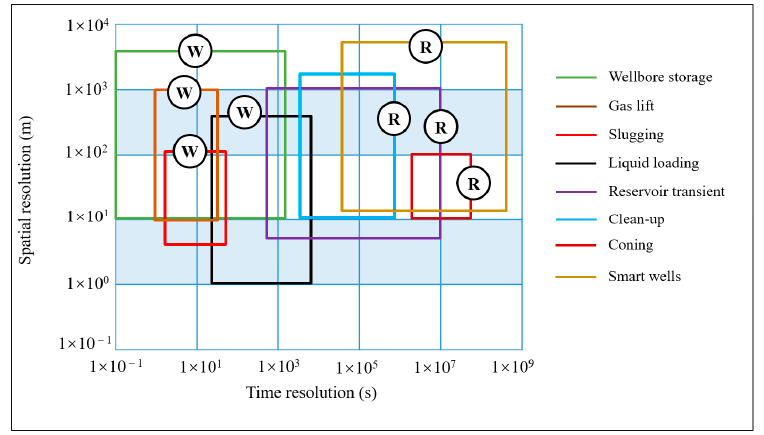
Figure 1. Spatial and time scales for the reservoir (R) and wellbore (W) phenomena. This figure was modified from Figure 1 in ref [4].